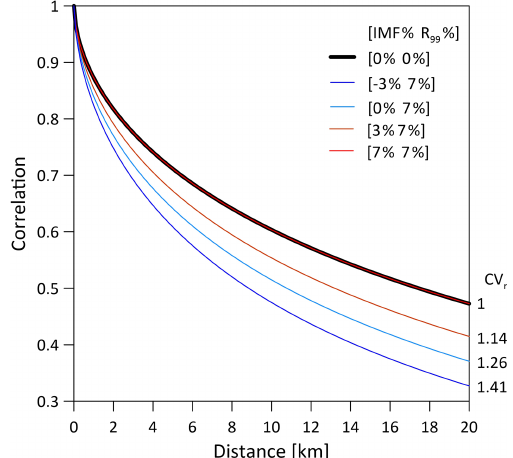
Figure 4. Spatial correlation of the rainfall fields that are presented in Fig. 3 for the specific case of (cid:49)T = 3 ◦ C. The correlation is com- puted on the spectral densities of the fields following Peleg et al. (2019) and for each case the spatial coefficient of variation of the field CV r is given. IMF refers to changes in the mean areal rainfall (% ◦ C − 1 ) and R 99 refers to changes in the peak rainfall intensity (% ◦ C − 1